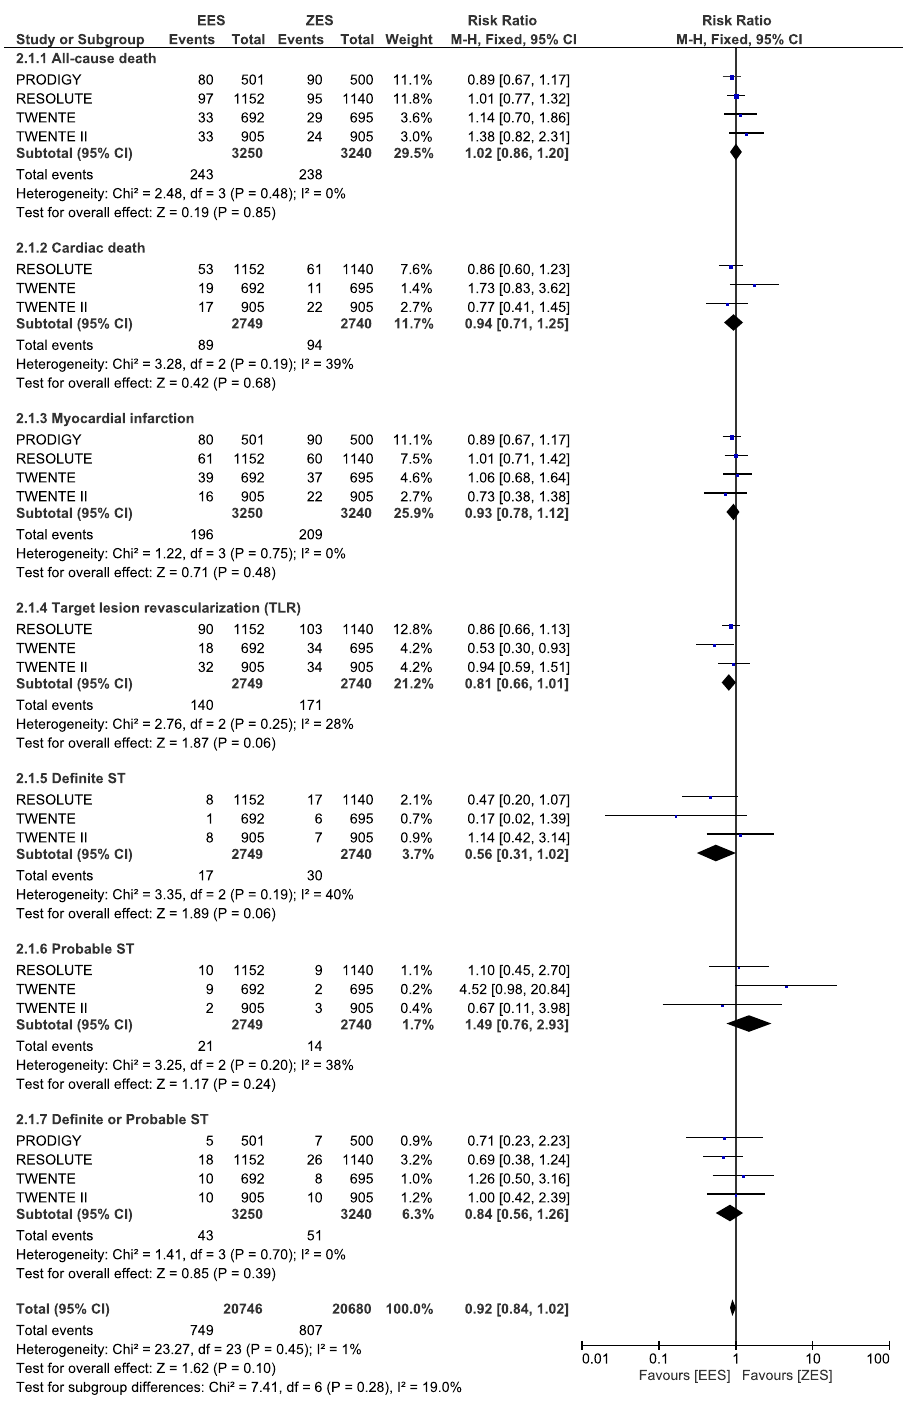
Figure 13. Long-term adverse outcomes which were observed with ZES versus EES (part